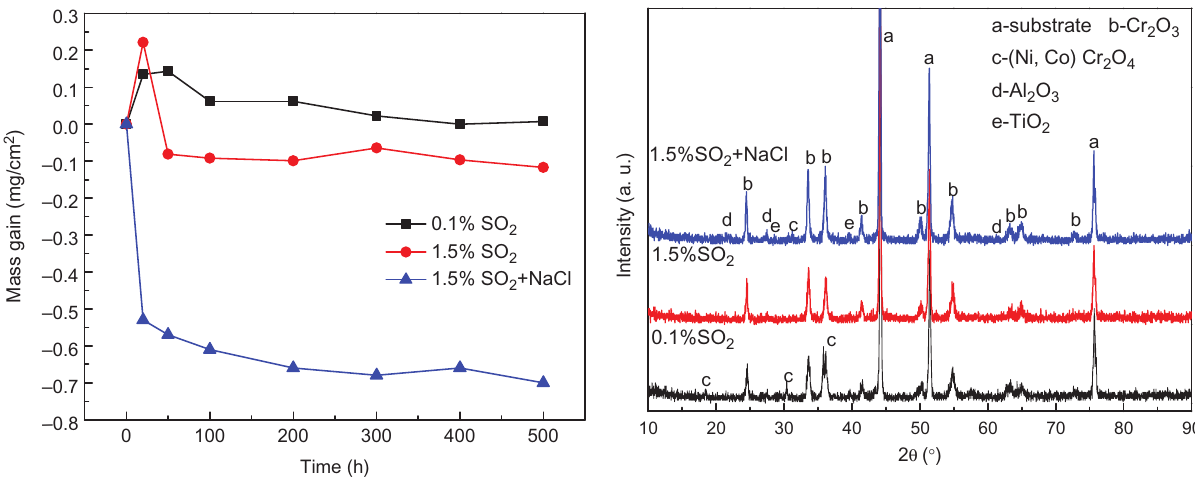
Figure 3: XRD patterns of samples corroded at 750°C for